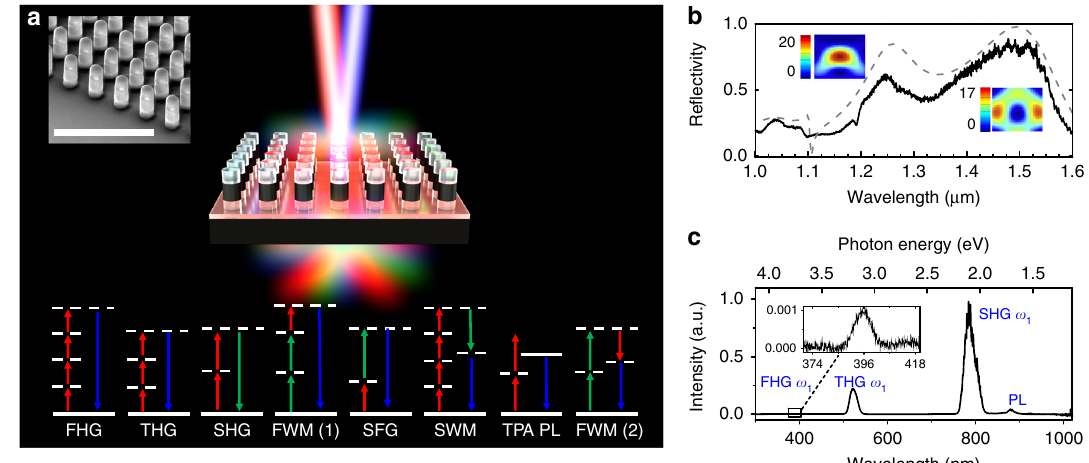
Fig. 1 Generation of new frequencies with the GaAs metasurface mixer. a Schematic of an optical metamixer consisting of a square array of subwavelength GaAs dielectric resonators. Two femtosecond near-IR pulses pump the metamixer and a variety of new frequencies are simultaneously generated. Inset: a 60° side-view scanning electron microscope image of the GaAs metamixer. The scale bar corresponds to 3 μ m. Bottom inset: schematic energy diagrams of the seven nonlinear optical processes that occur simultaneously in our metamixer: second-hamonic generation (SHG), third-harmonic generation (THG), fourth-harmonic generation (FHG), sum-frequency generation (SFG), two-photon absorption-induced photoluminescence (TPA PL), four-wave mixing (FWM) and six-wave mixing (SWM). b Measured (solid line) and numerically simulated (dashed line) re fl ectance spectra of the metasurface with two cross-section local electric fi eld distributions at the wavelengths of 1.246 μ m and 1.535 μ m, which correspond to the maximal electromagnetic fi eld enhancements inside the GaAs nanodisk. c Spectra of second-, third- and fourth-harmonics when pump pulses of λ 1 ~ 1.57 μ m are used to excite the GaAs metamixer. Inset is the zoom-in of the fourth harmonic